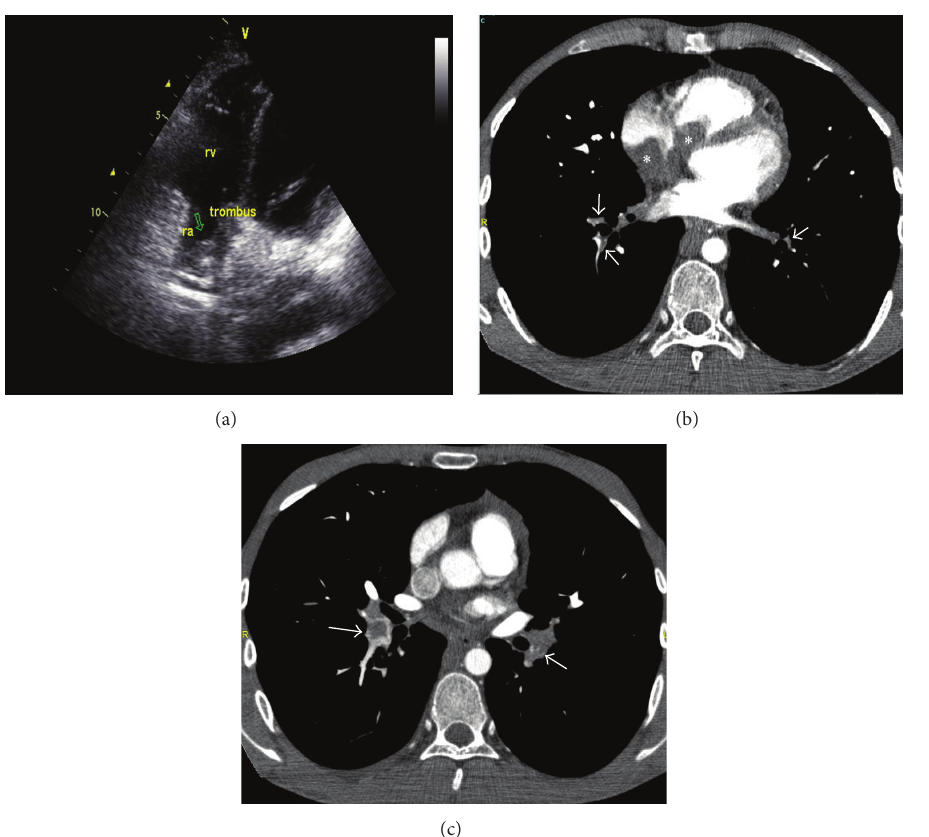
Figure 3: (a) Transthoracic echocardiography showed a mobile mass filling the half of the right atrium ( 4.5×3 cm in size) (arrow) extending the right ventricule ( 1.5 × 1.6 cm in size) and into the vena cava. (b) Contrast-enhanced CT angiographic image shows a large filling defect in the right atrium extending into the right ventricle (asterisks). Segmental arteries in both lower lobes are of small calibre due to chronic thromboembolism (arrows). Pulmonary hypertension resulted in straightening of the interventricular septum. (c) Both lower lobe arteries contain central filling defects (arrows) representing superimposed acute pulmonary